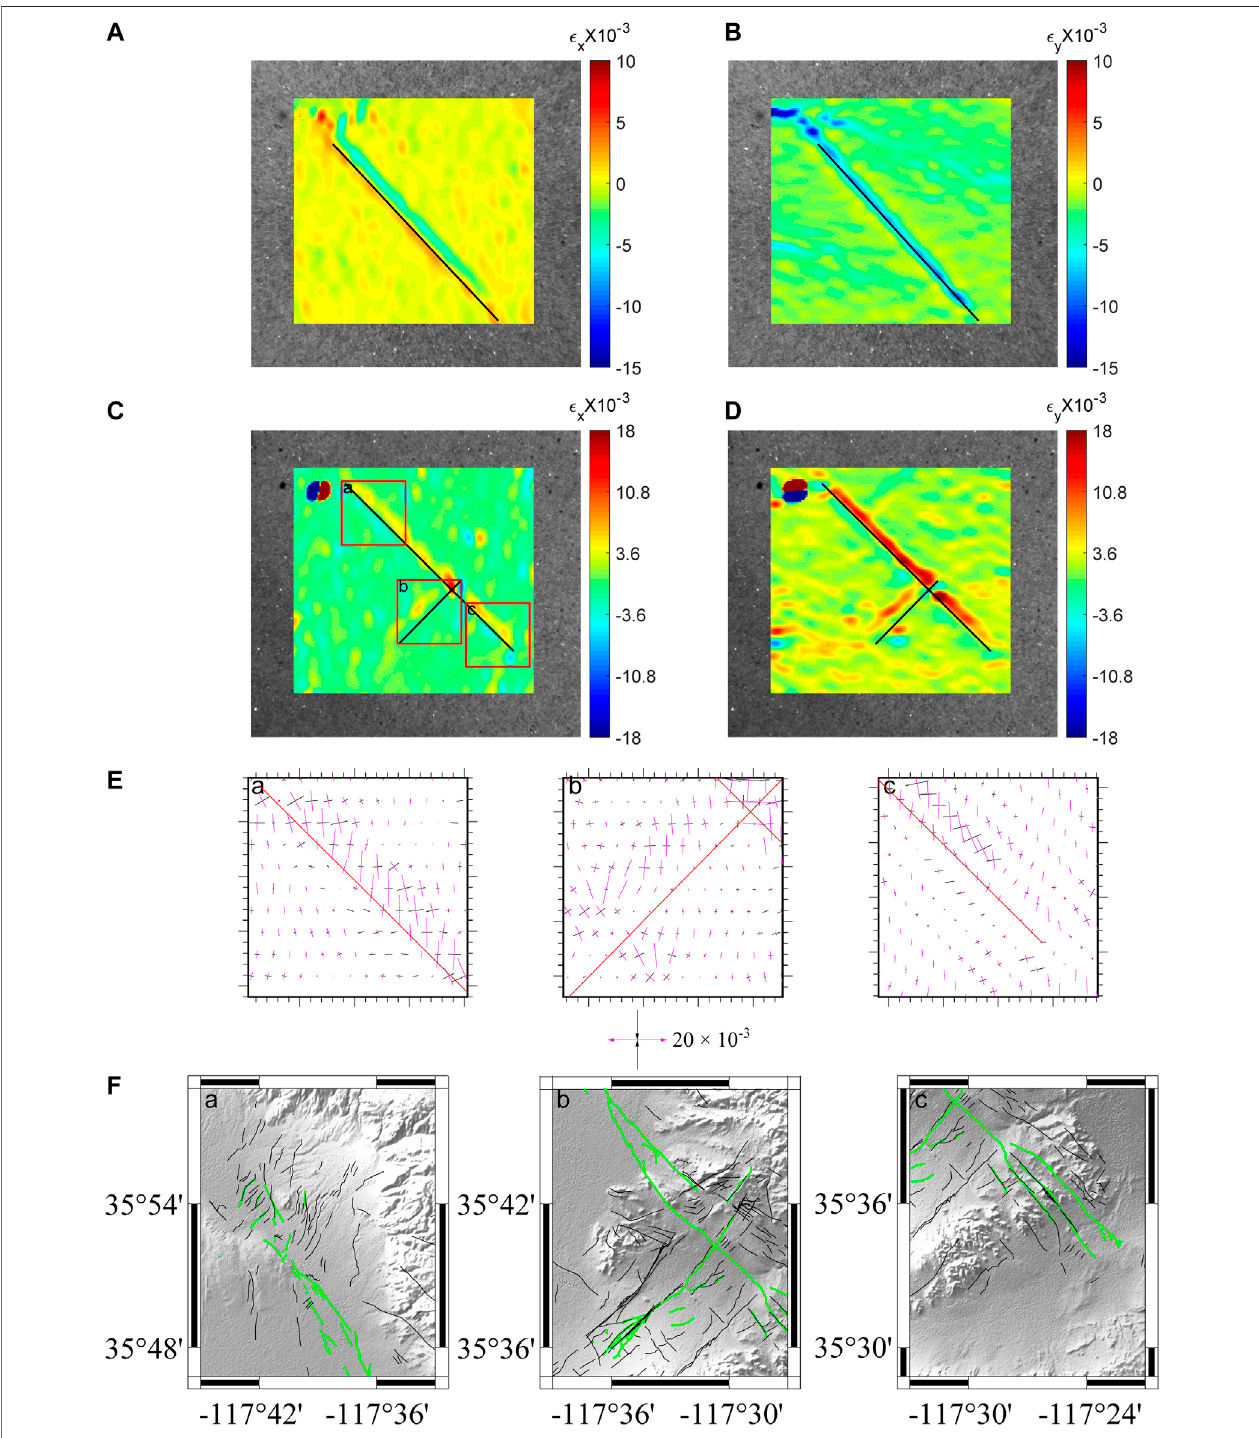
FIGURE 7 | Strain fi elds observed before the marble samples were broken. Colors represent the strain in the direction of X -axis (A) and Y -axis (B) of the marble sample with only one prefabricated fault and of the marble sample with two orthogonal prefabricated faults (C) and (D) , respectively. Positive values indicate tensional strain along the corresponding axis, while negative values indicate compressional strain along the axis. The black line indicates the prefabricated fault, and the loading direction is along the negative direction of Y -axis. The principal strain axes within the red rectangles in (C) are shown in (E) . The red lines indicate the prefabricated faults, and the black lines represent compression, while the magenta lines represent extension. Surface fractures produced by the earthquake sequence in the corresponding areas are shown in (F) for comparison.